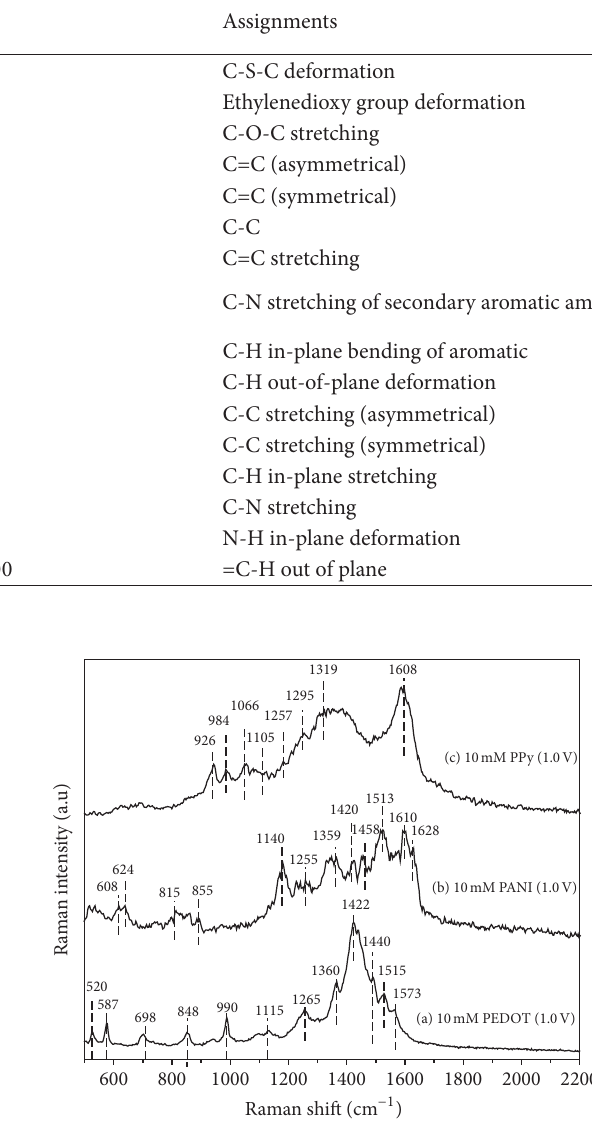
electropolymerized at 1.0V in 10mM monomer containing 0.1M LiClO 4